Question: Does the plotted quantity increase or decrease?
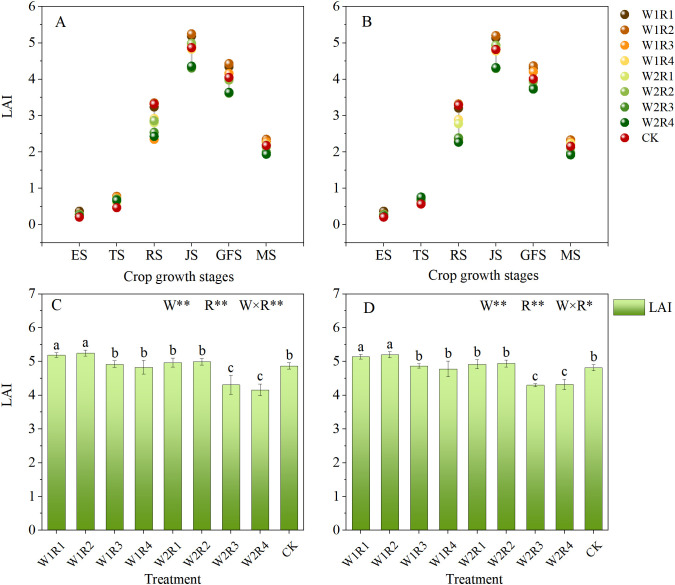
Answer: increasing